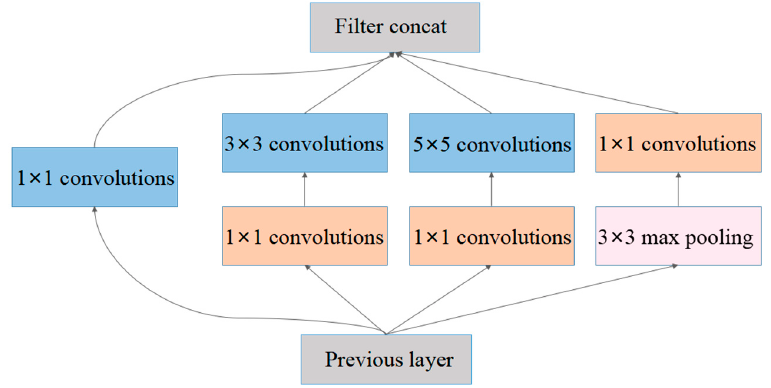
Figure 10. Inception ‐ v1 module.